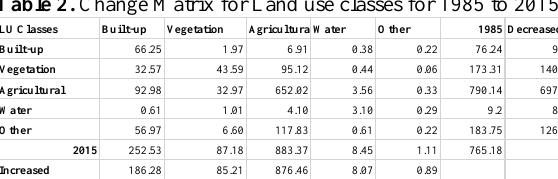
Table 2. Change Matrix for Land use classes for 1985 to 2015. LU Classes Built-up Vegetation AgriculturalWater